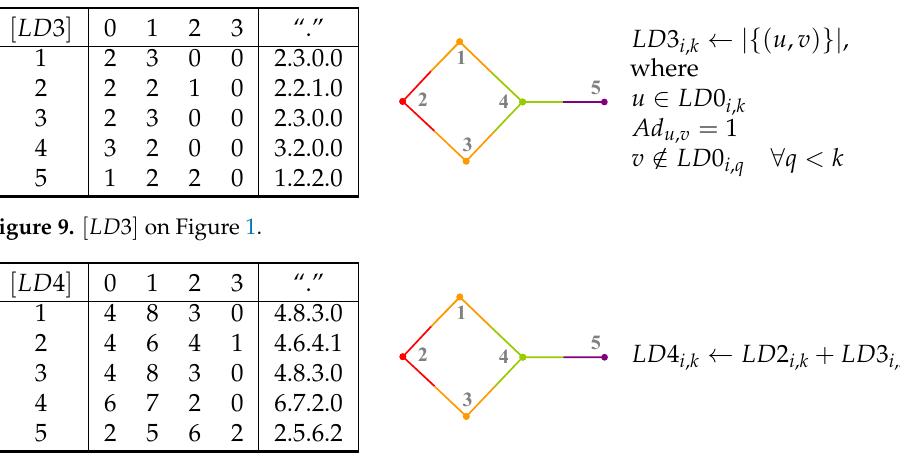
Figure 10. [ LD 4 ] on Figure 1.